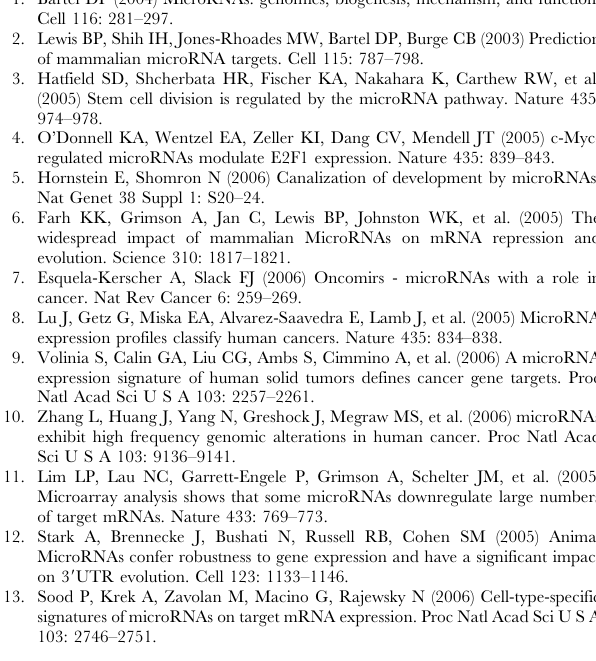
Table S6 GO annotation enrichment analysis for the targets